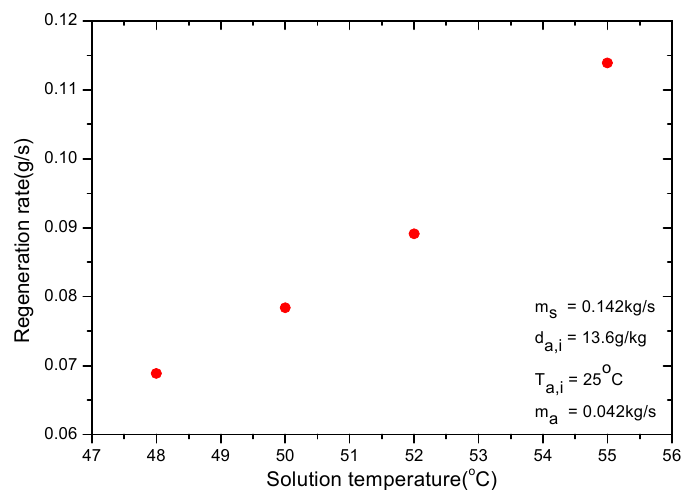
Figure 7. Influence of solution temperature on